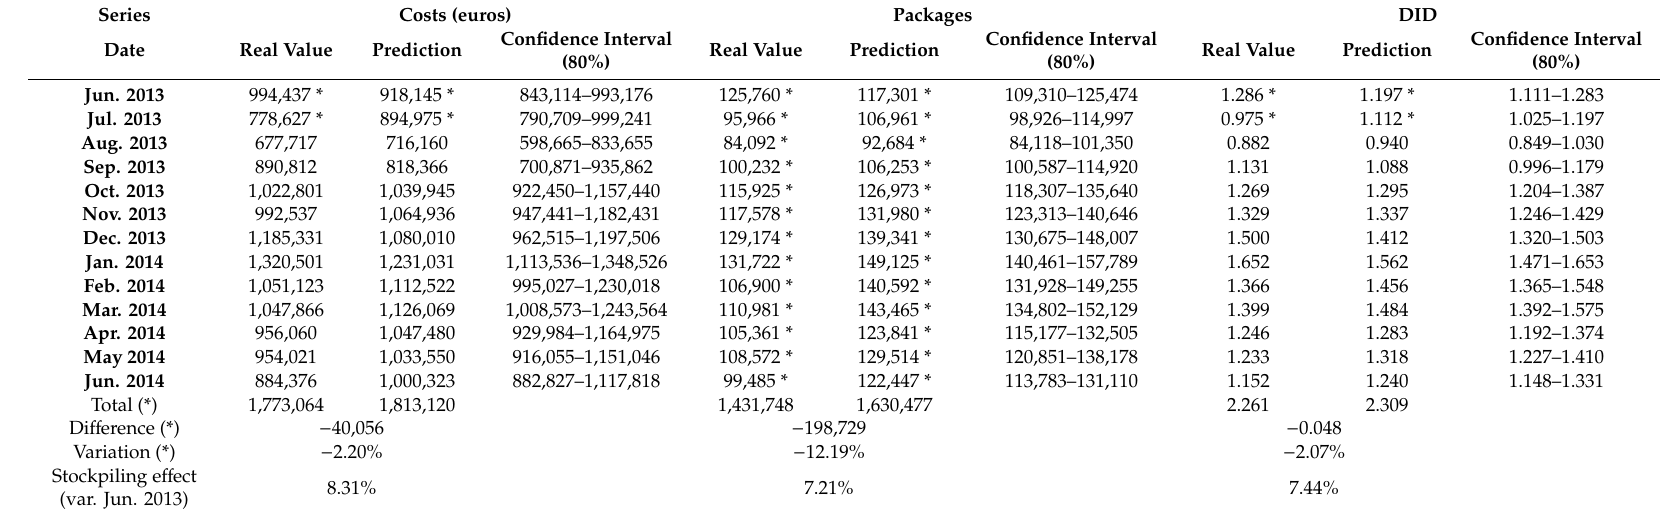
Table A1. Savings from the introduction of RDL no. 16 / 2012 (predictions with the ARIMA models in Table